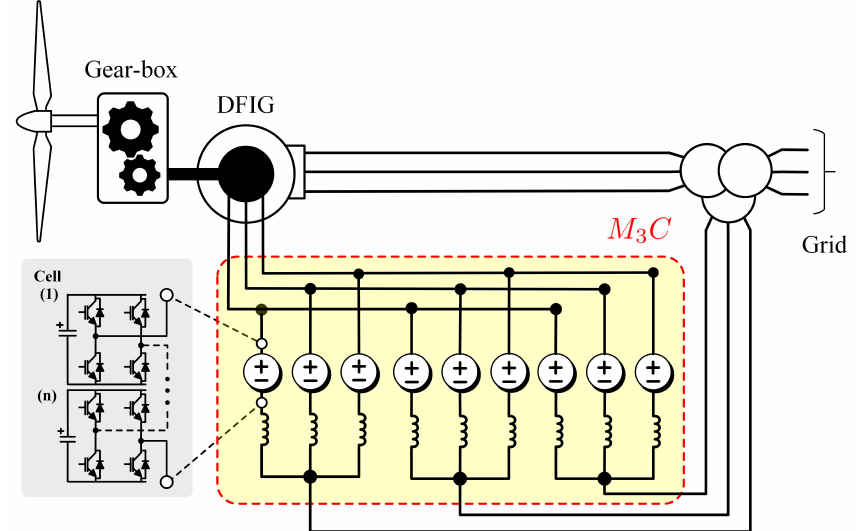
Figure 9. Topology based on an M 3 C to improve the performance of doubly-fed induction generators during low-voltage ride-through conditions (see